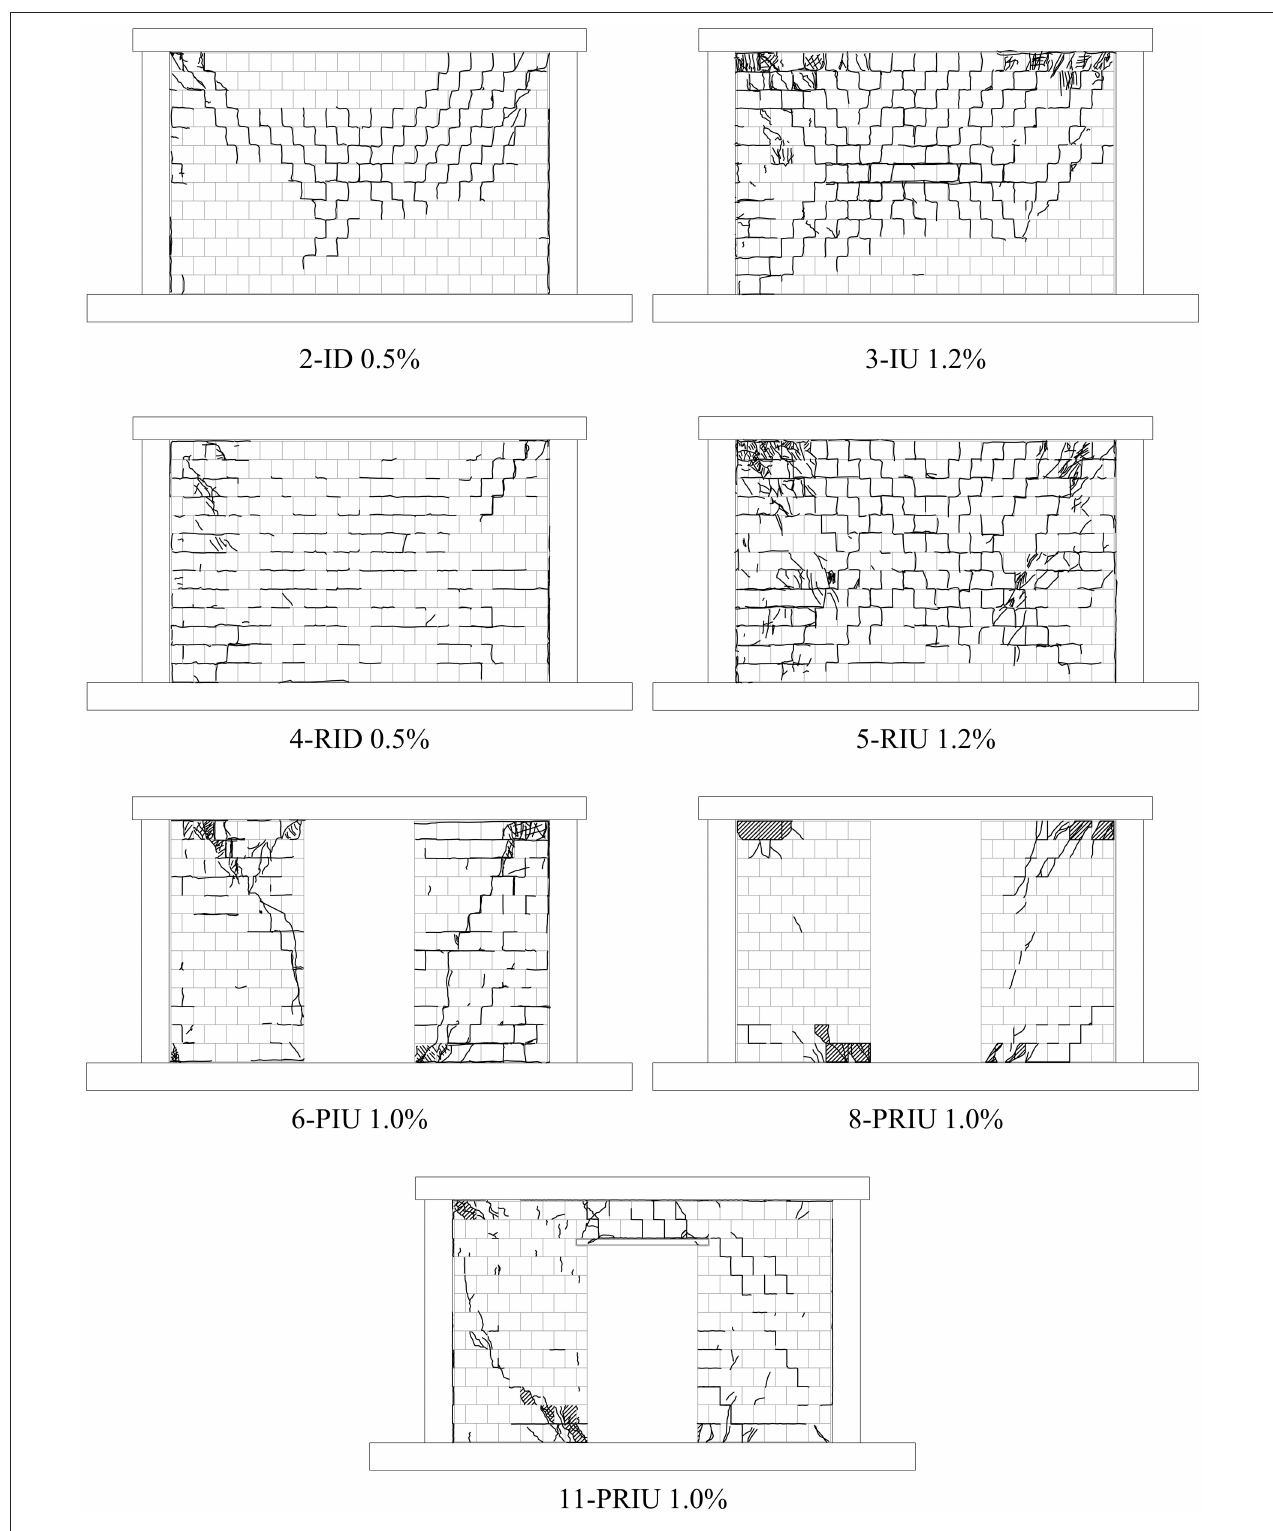
FIGURE 7 | Crack pattern at the end of the in-plane tests.